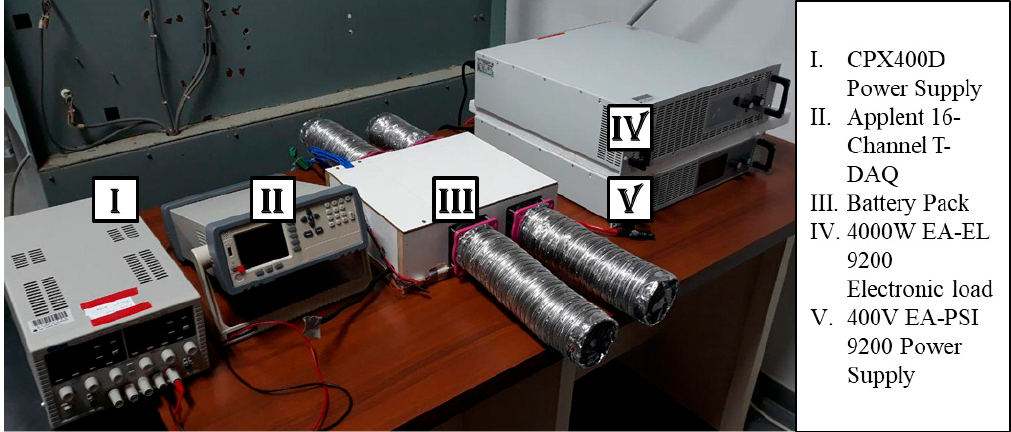
Figure 5. Experimental setup.